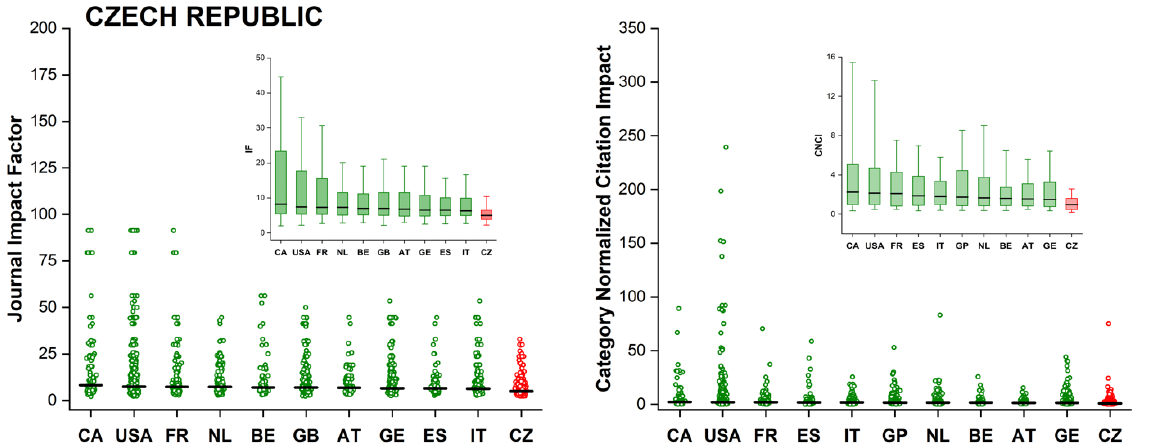
Figure 4. Scientific impact (JIF and CNCI) as a function of the country of affiliation of corresponding authors in the Czech Republic. JIF and CNCI were plotted against the country of origin of the corresponding authors. Open circles represent the observed IF and CNCI values; black line corresponds to the calculated median value. Red open circles: Czech Republic; green open circle: countries with an observed significant difference. The order of plotted countries corresponds to the calculated median value. Insets: For better visibility, the same results were plotted as a box plot. The black line corresponds to the median value, the bottom and top lines show the 1st and 3rd quartile and whiskers show 10–90% outliers. Abbreviations: AT = Austria, BE = Belgium, CA = Canada, CZ = Czech Republic, ES = Spain, GB = England, FR = France, GE = Germany, IT = Italy, NL = the Netherlands, USA = United States.